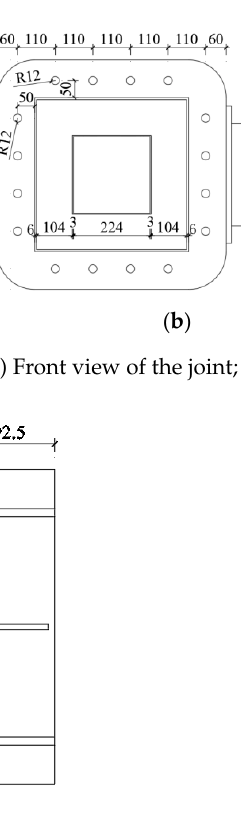
Figure 4. Dimensions of the connecting block (unit: mm): ( a ) Front view of the connecting block; ( b ) Left view of the connecting block.